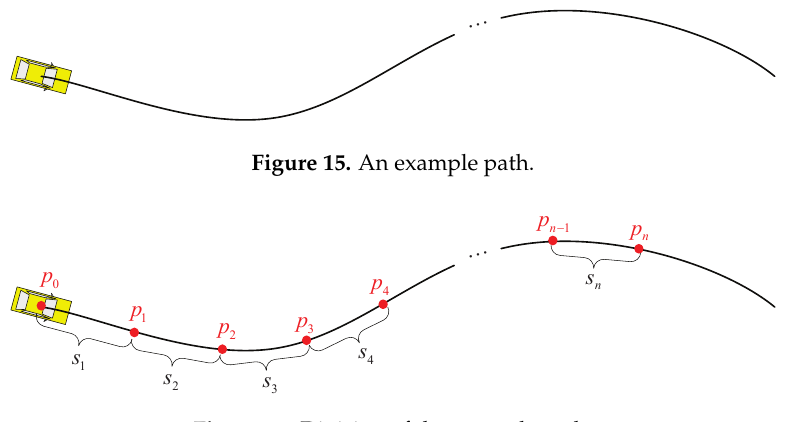
Figure 16. Division of the example path.